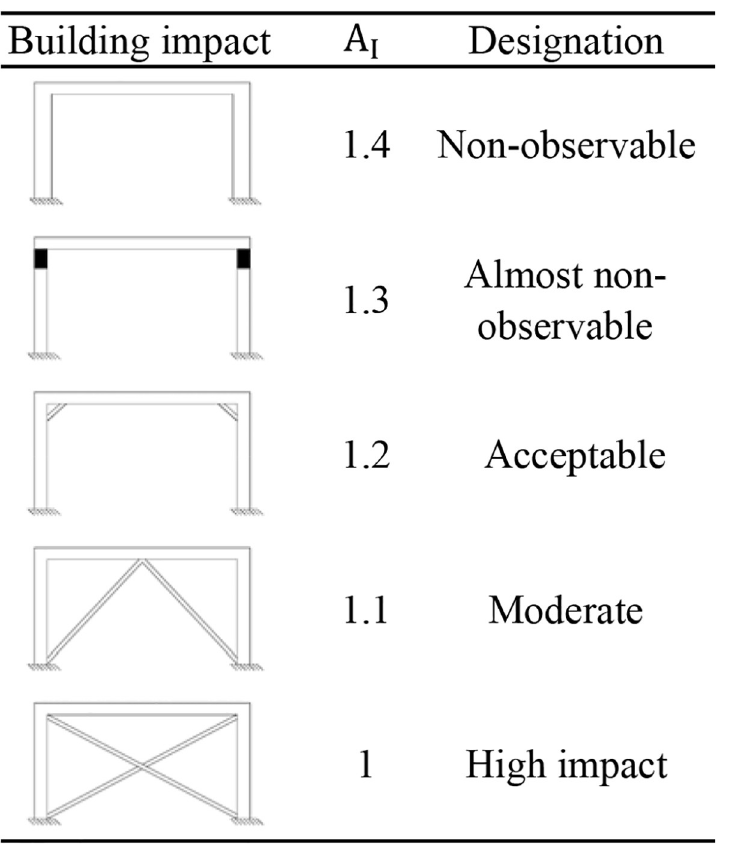
Fig 2. Classification of the A I